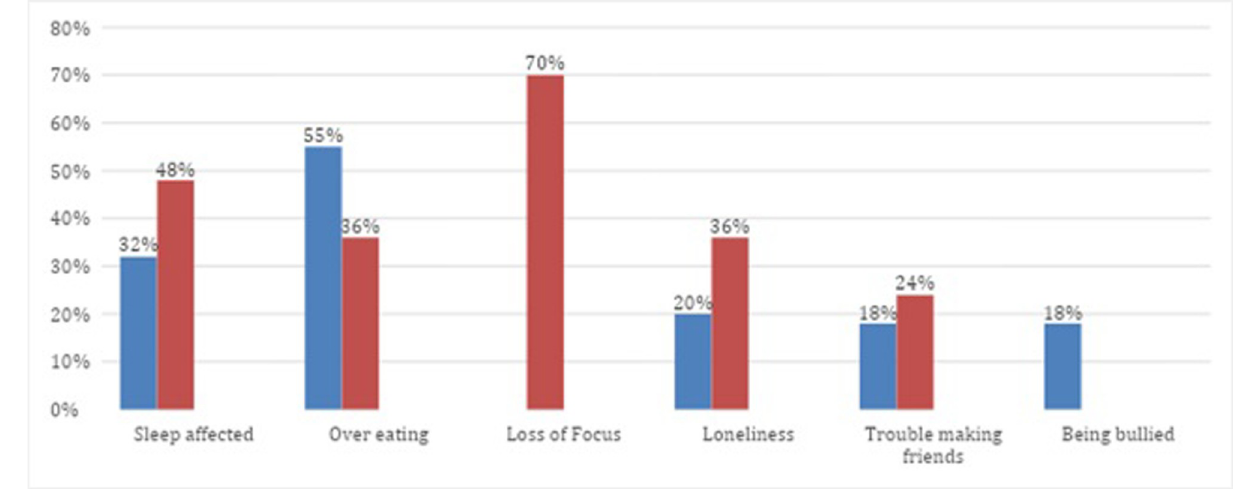
Fig 1. Refugees emotional health challenges among children and